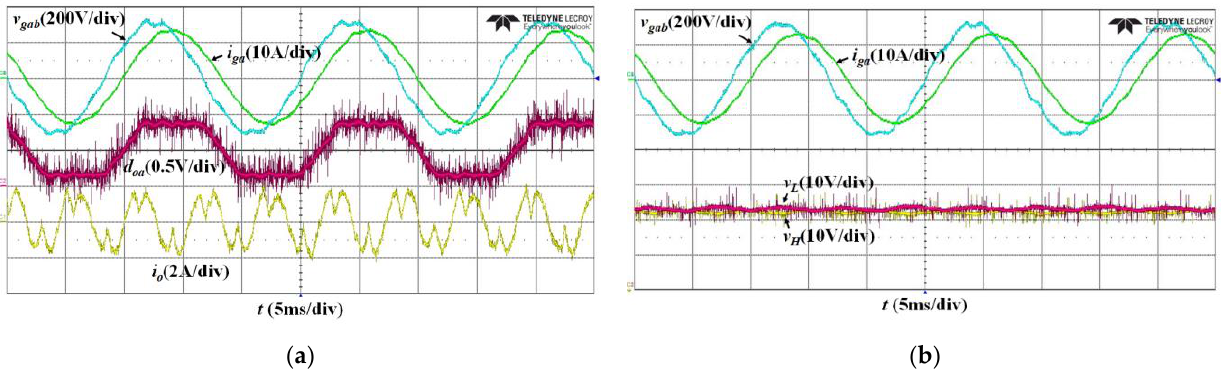
Figure 10. Experimental waveforms under unbalanced load condition corresponding to 40% deviation of output power. ( a ) v gab : grid line-to-line voltage; i ga : grid current; d oa : final duty; i o : averaged neutral point current. ( b ) v gab : grid line-to-line voltage; i ga : grid current; v H , v L : DC-link voltage.